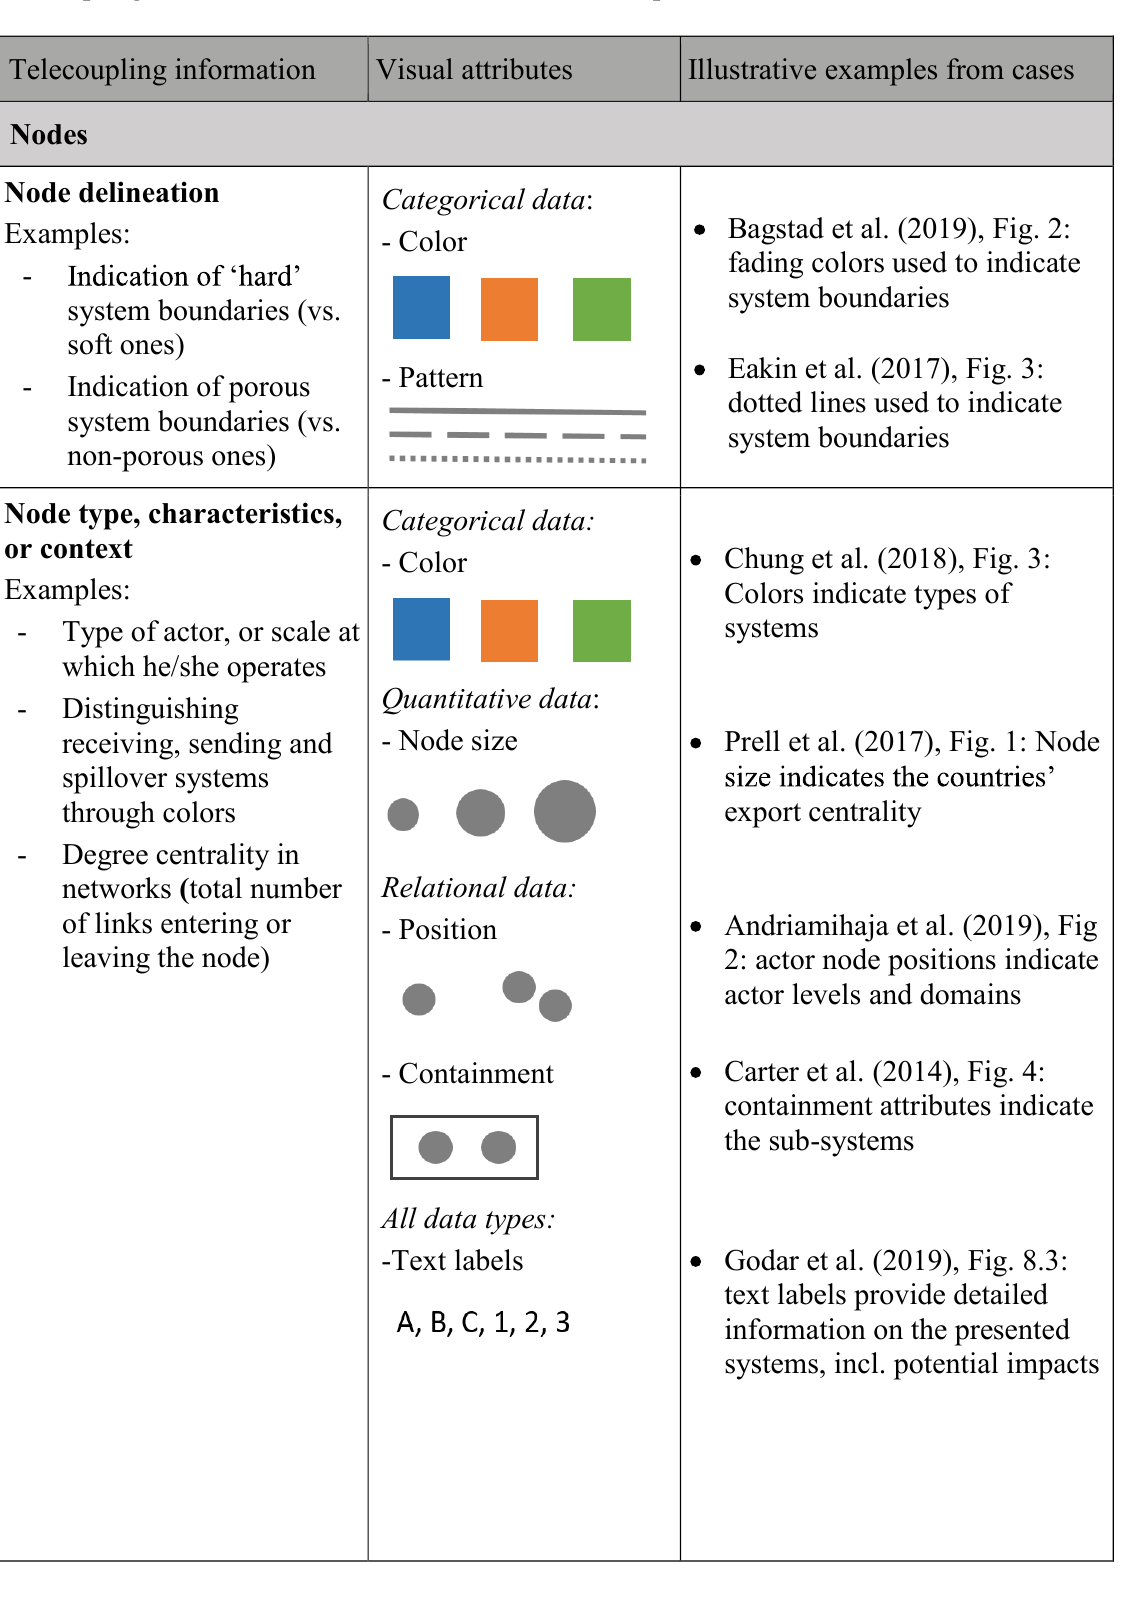
Figure A3.1 . Visual attributes in telecoupling